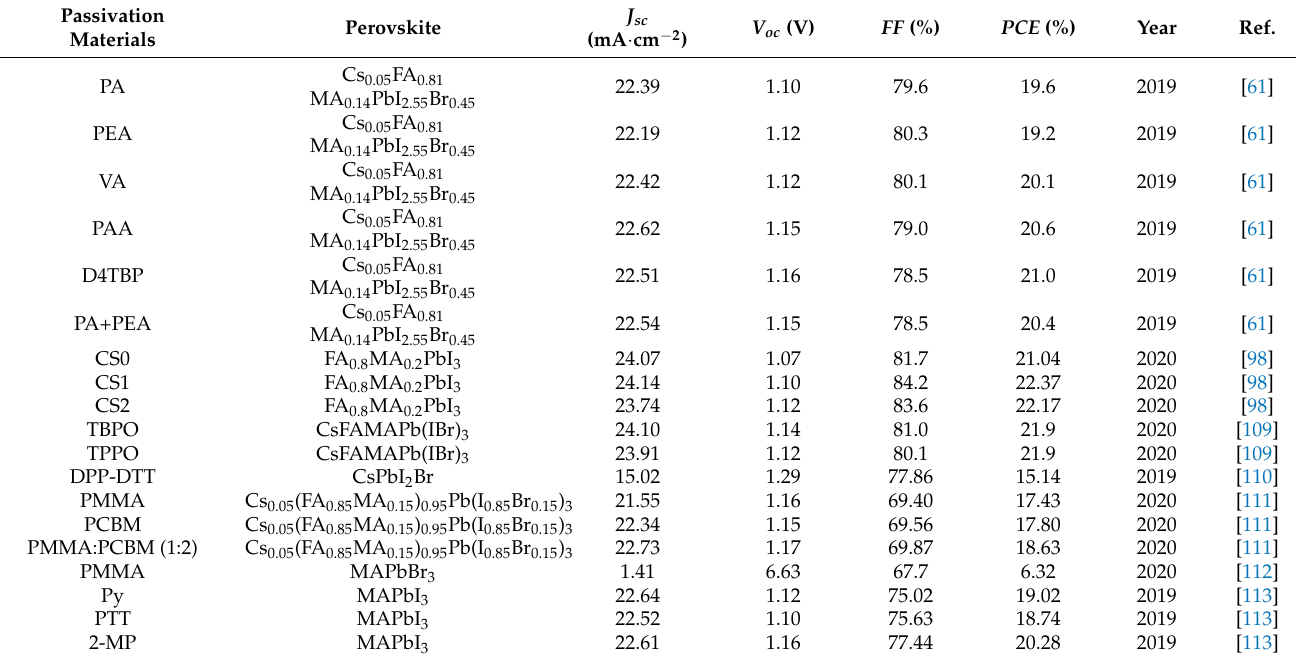
Table 2. Performance summary of chemical passivation